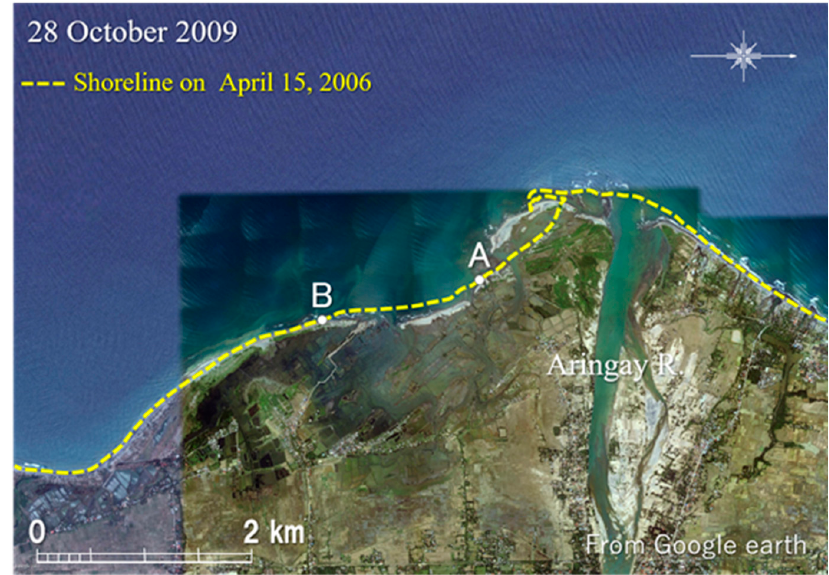
Figure 12. Satellite image of shoreline around Aringay River mouth (28 October 2009).